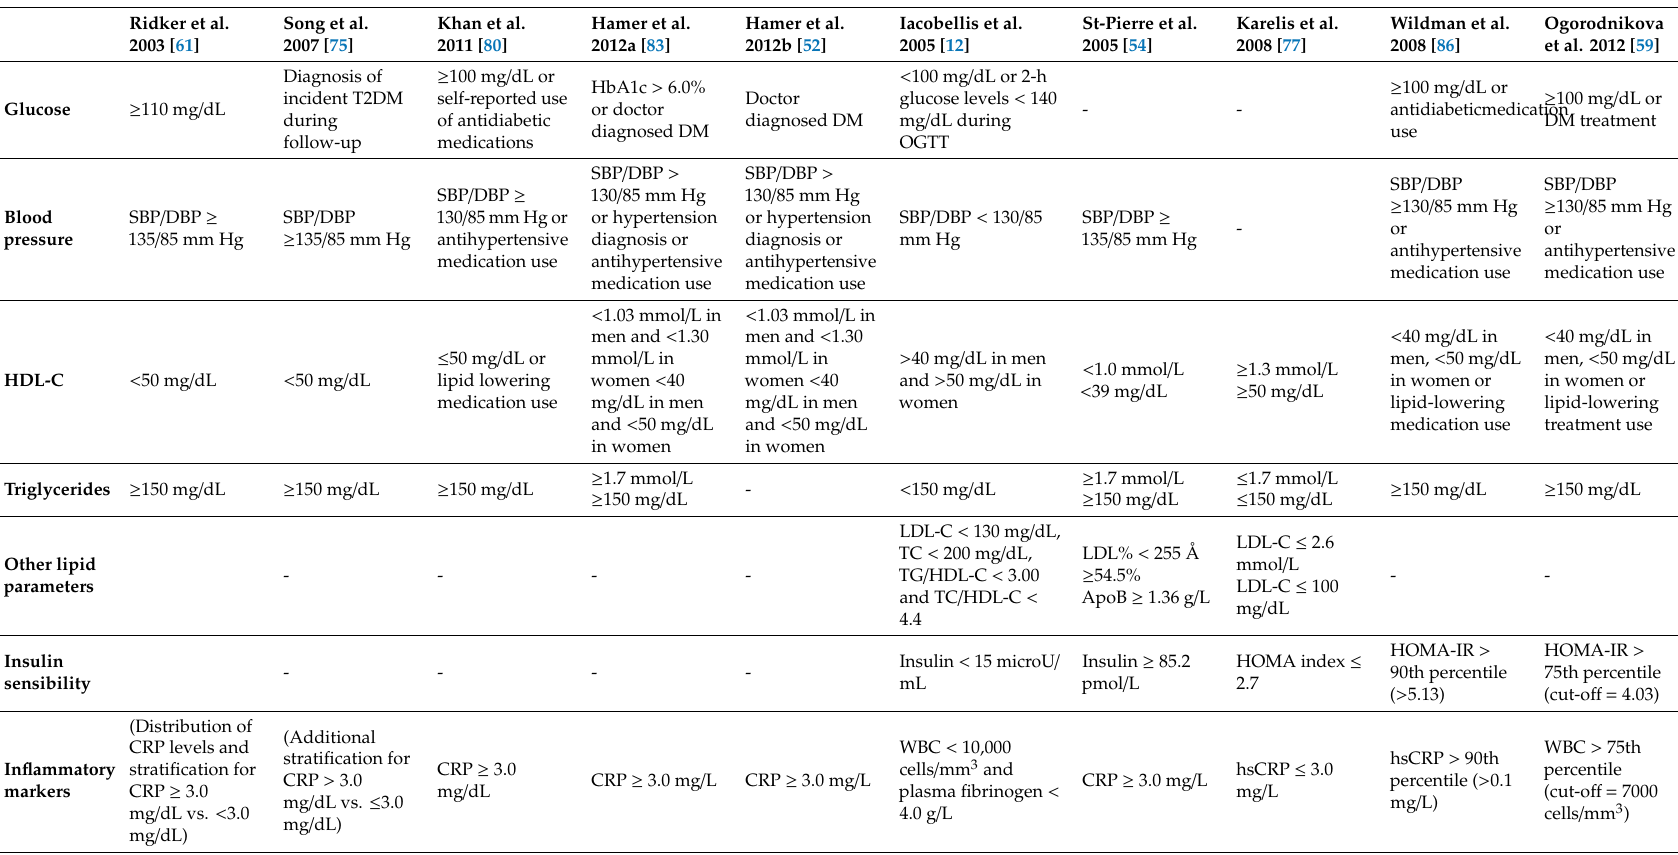
Table 2. Examples of metabolically healthy obese (MHO) definitions that include inflammatory